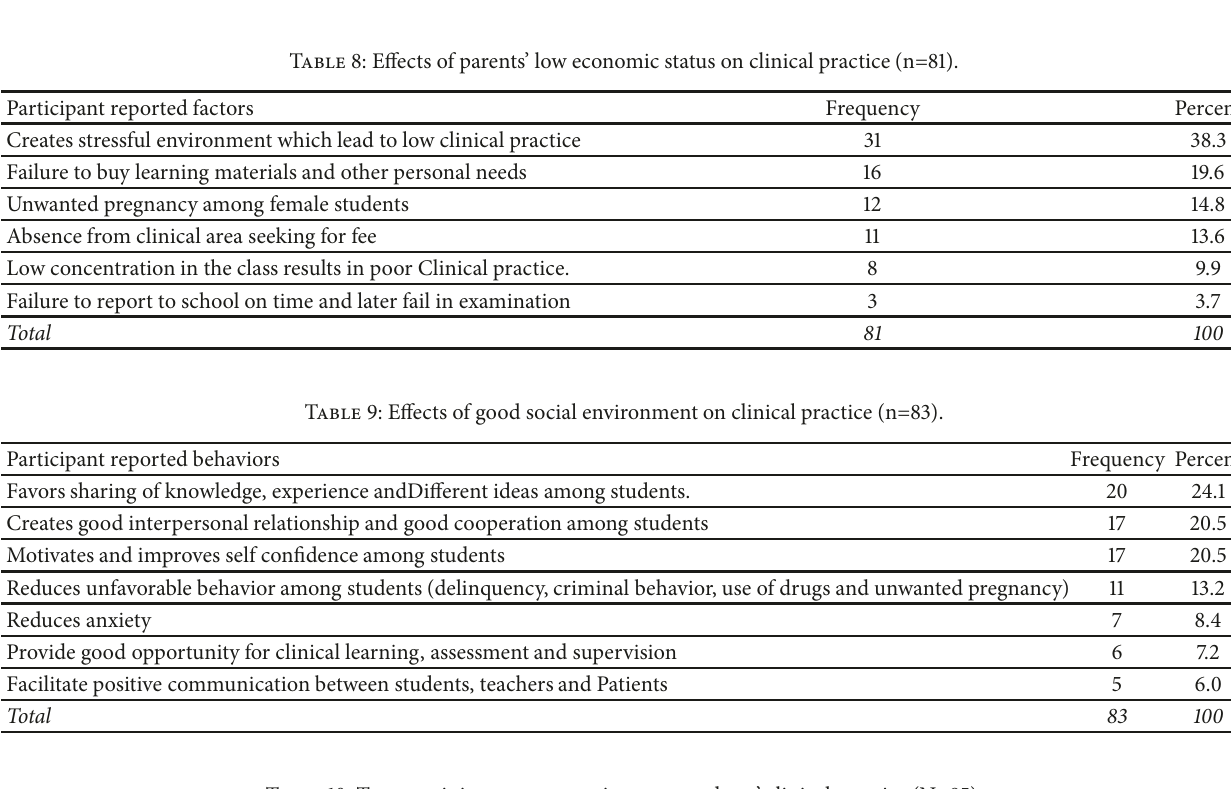
Table 10: Tutors opinions on ways to improve students’ clinical practice